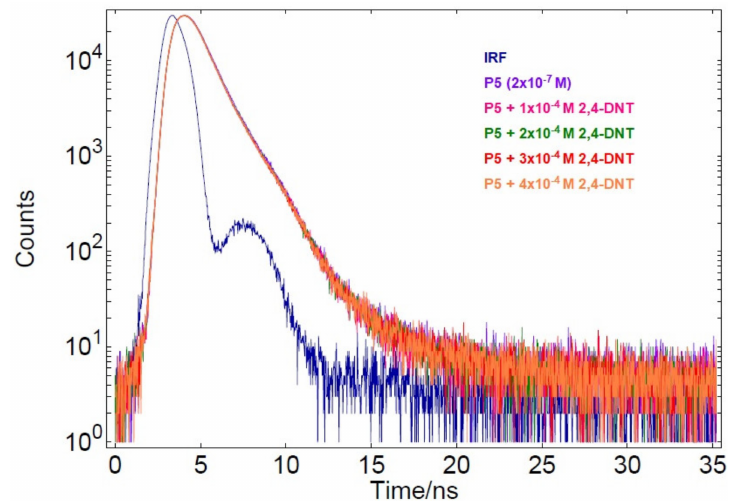
Figure 7. Fluorescence decay time curves of P5 with DNT in DCM at an excitation wavelength of 300 nm and an emission wavelength of 392 nm.